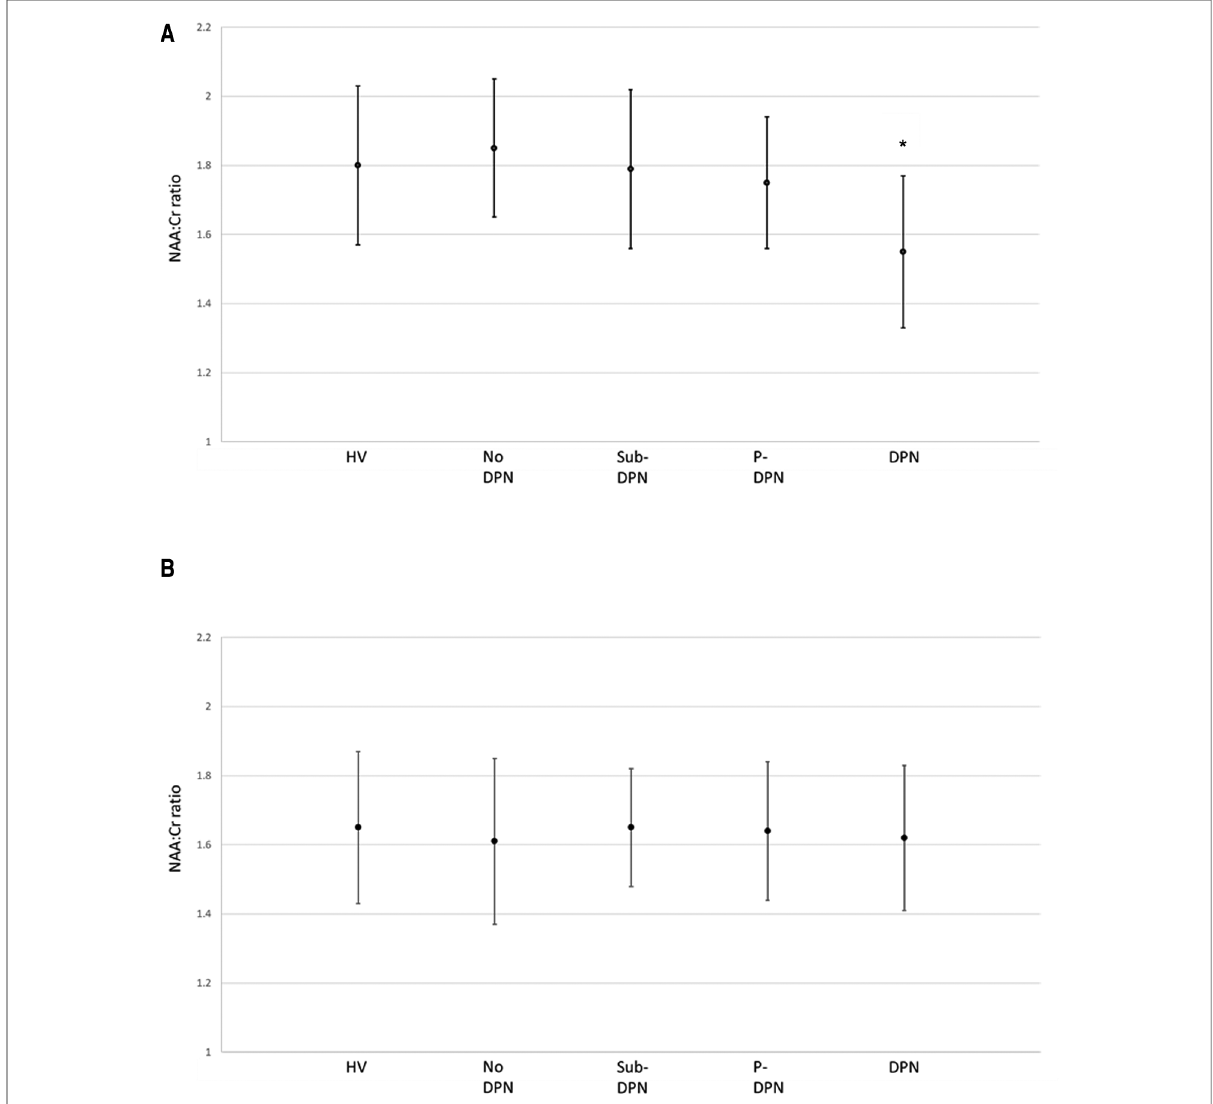
FIGURE 2 NAA:Cr ratio and 95% CI at the ( A ) thalamus and ( B ) primary somatosensory cortex. * p =<0.001. DPN, painless-DPN; HV, healthy volunteer; No DPN, diabetes without DPN; P-DPN, painful-DPN; Sub-DPN,